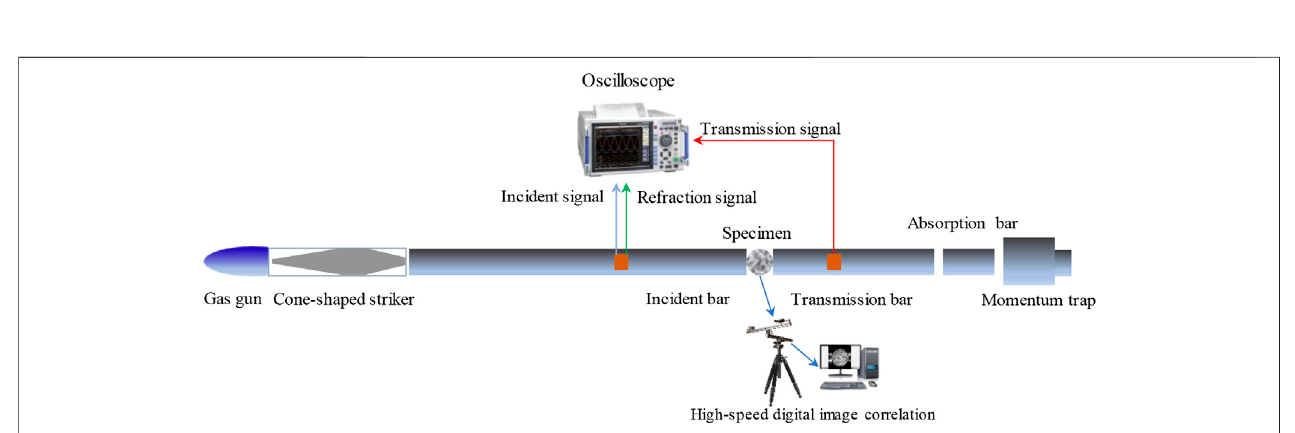
FIGURE 2 | SHPB, oscilloscope, and high-speed digital image correlation used in the rock dynamic tensile experiment.